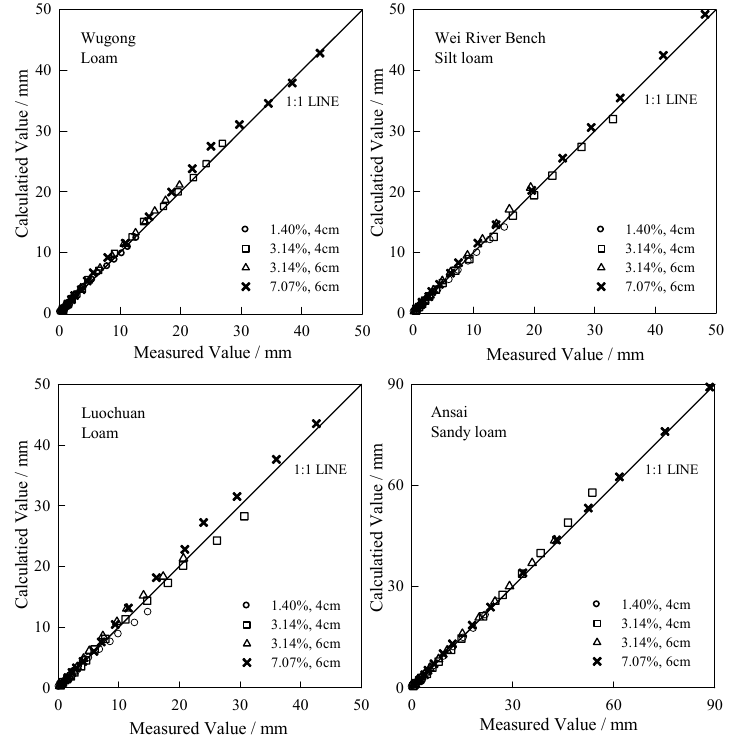
Measured Value / mm Figure 11. Comparison of four soil types between calculated values and measured values of cumulative infiltration.